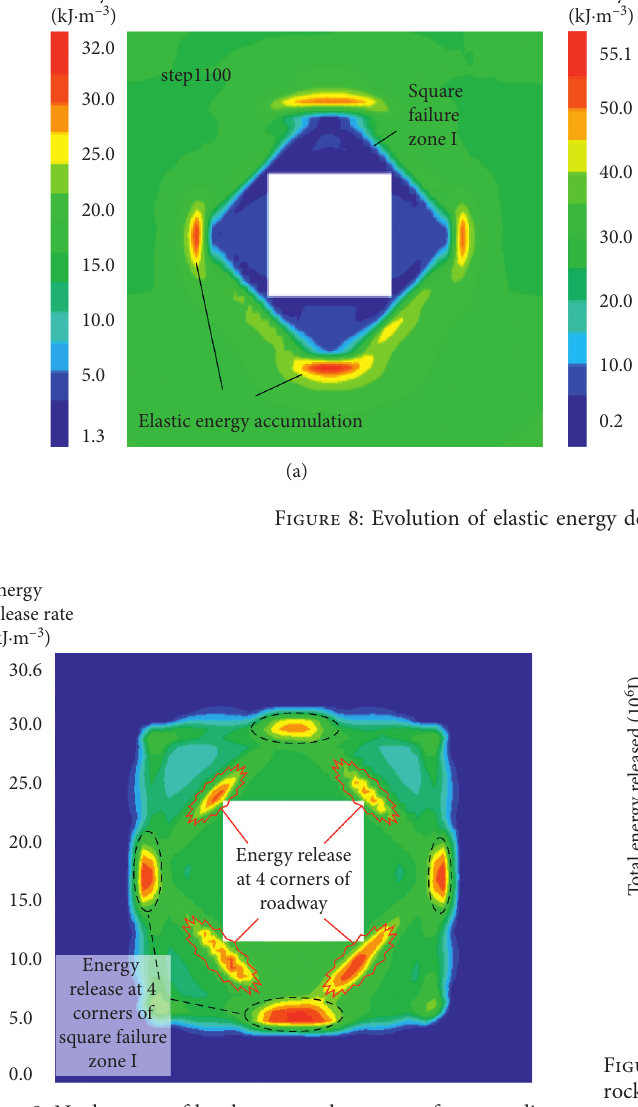
Figure 9: Nephogram of local energy release rate of surrounding rock.